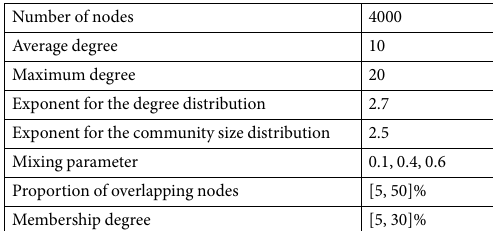
Table 4. LFR network